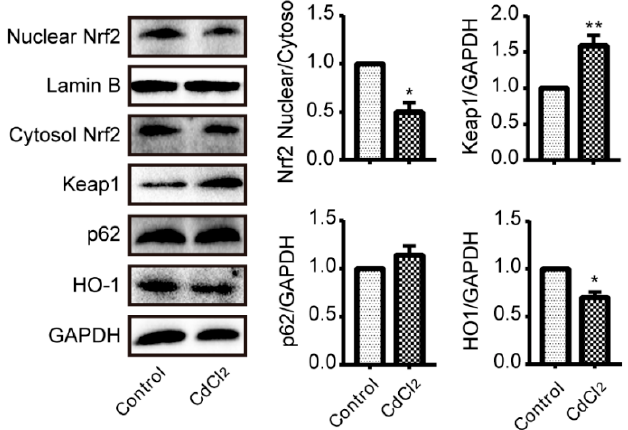
Figure 4. Cd inhibited Nrf2 signaling pathway in mouse liver ( n = 4). Western blotting analysis of Nrf2, Keap1, p62 and HO-1. The density of the western blotting was normalized for GAPDH / Lamin B. * p < 0.05, ** p < 0.01 as compared to control.